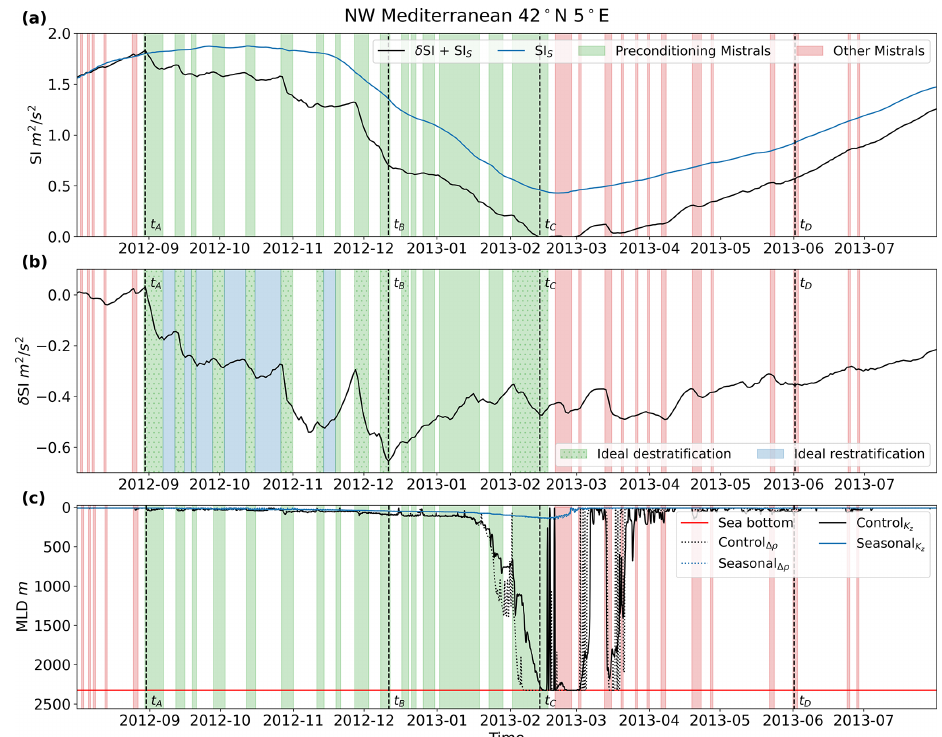
Figure 8. The stratification index of the nearest NEMO grid point to 42 ◦ N, 5 ◦ E and MLD over the year of both simulations. Panel (a) shows the stratification index for the control run, SI S + δ SI, and the seasonal run, SI S . Panel (b) shows the difference between the control and seasonal stratification index, δ SI. Panel (c) shows the MLD for both simulations. Mistral events are shown in all three panels and are colored green for events during the preconditioning and deep-convection phase and red for events outside of the preconditioning phase. Mistral events with dotted hatching (the blue-colored intervening time between events) are used as ideal destratification (restratification) events to compute the simple model restoration coefficients. The specific timestamps t A through t D correspond to the timestamps of the plots in Fig. 7: 30 August 2012, 11 December 2012, 13 February 2013, and 1 June 2013. Two definitions of MLD are plotted in (c) : one calculated by a vertical change in density less than 0.01kgm − 3 , denoted by (cid:49)ρ , and one calculated by a vertical diffusivity less than 5 × 10 − 4 m 2 s − 1 , denoted by K z . The MLD denoted by the vertical diffusivity criteria follows the turbocline depth and is taken to represent the mixed-layer depth more accurately, as it matches the deep-convection timing in the stratification